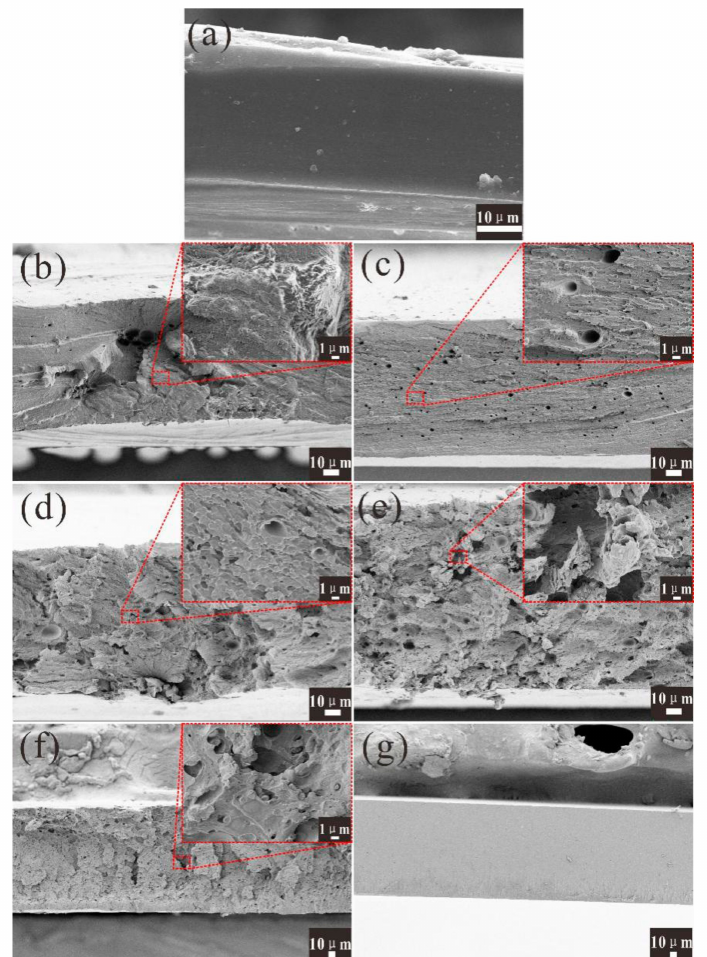
Figure 5. FESEM fractographs of FPI, FPI / FHBPI composites and FHBPI. ( a ) Pure FPI, ( b ) FPI / FHBPI-5%, ( c ) FPI / FHBPI-10%, ( d ) FPI / FHBPI-15%, ( e ) FPI / FHBPI-20%, ( f ) FPI / FHBPI-25%, ( g )